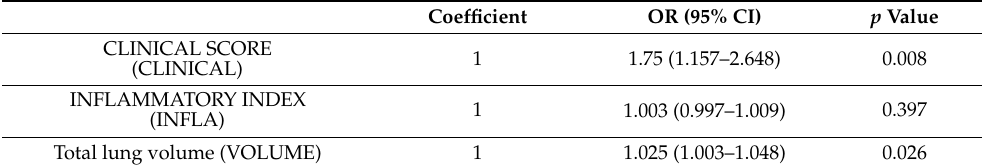
Table 3. Association of Clinical score, CT Parameters and Inflammatory index score with risk of ventilation and death in Multivariable Logistic Regression Analysis (Odds Ratios and Wald confidence intervals).